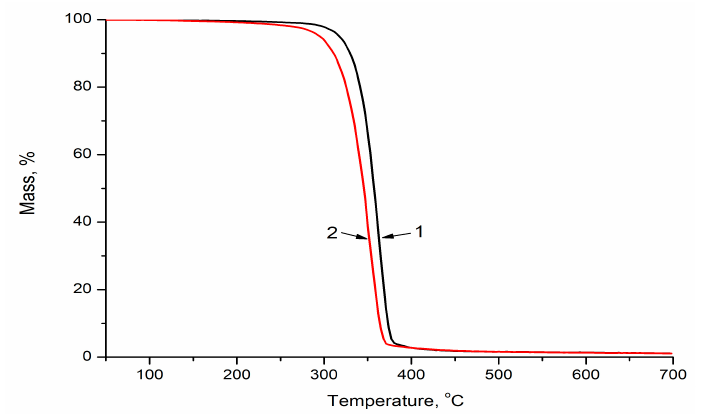
Figure 5. TGA thermograms of PLA/NR samples with 10% wt. of NR content: 1—initial, and 2—after 180 days of hydrolytic degradation.